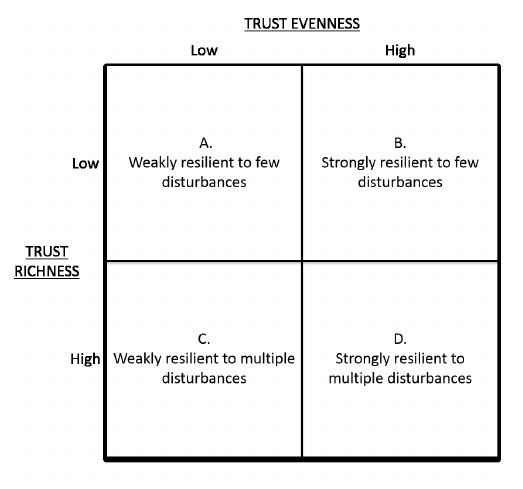
Fig. 1. Theoretical relationships between trust evenness, trust richness, and institutional resilience to disturbances.